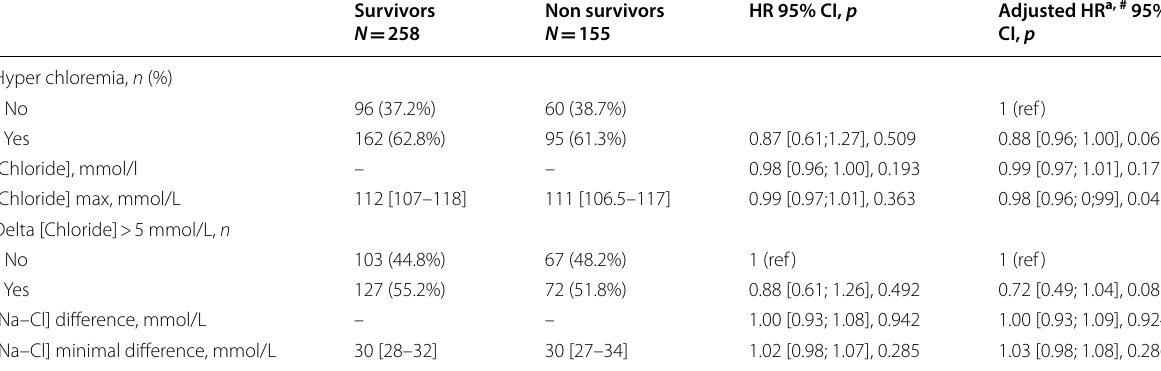
a Adjusted for hyperoxia group, age, MacCabe, SAPS, SOFA, Hyperlactatemia, Serum creatinine and ARDS at H0 and for the following time-dependent variable: Serum creatinine, vasopressor dose, Serum lactate and volume of fluid resuscitation # Adjusted models were developed in the 352 patients without missing